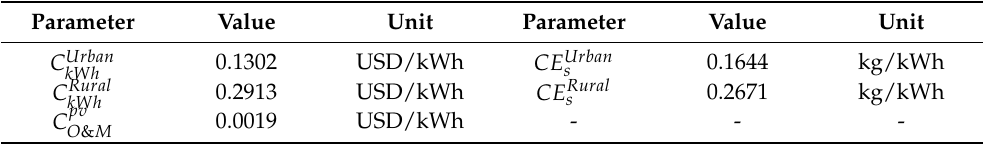
Table 4. Parameters to evaluate the objective function in the proposed NLP formulation.